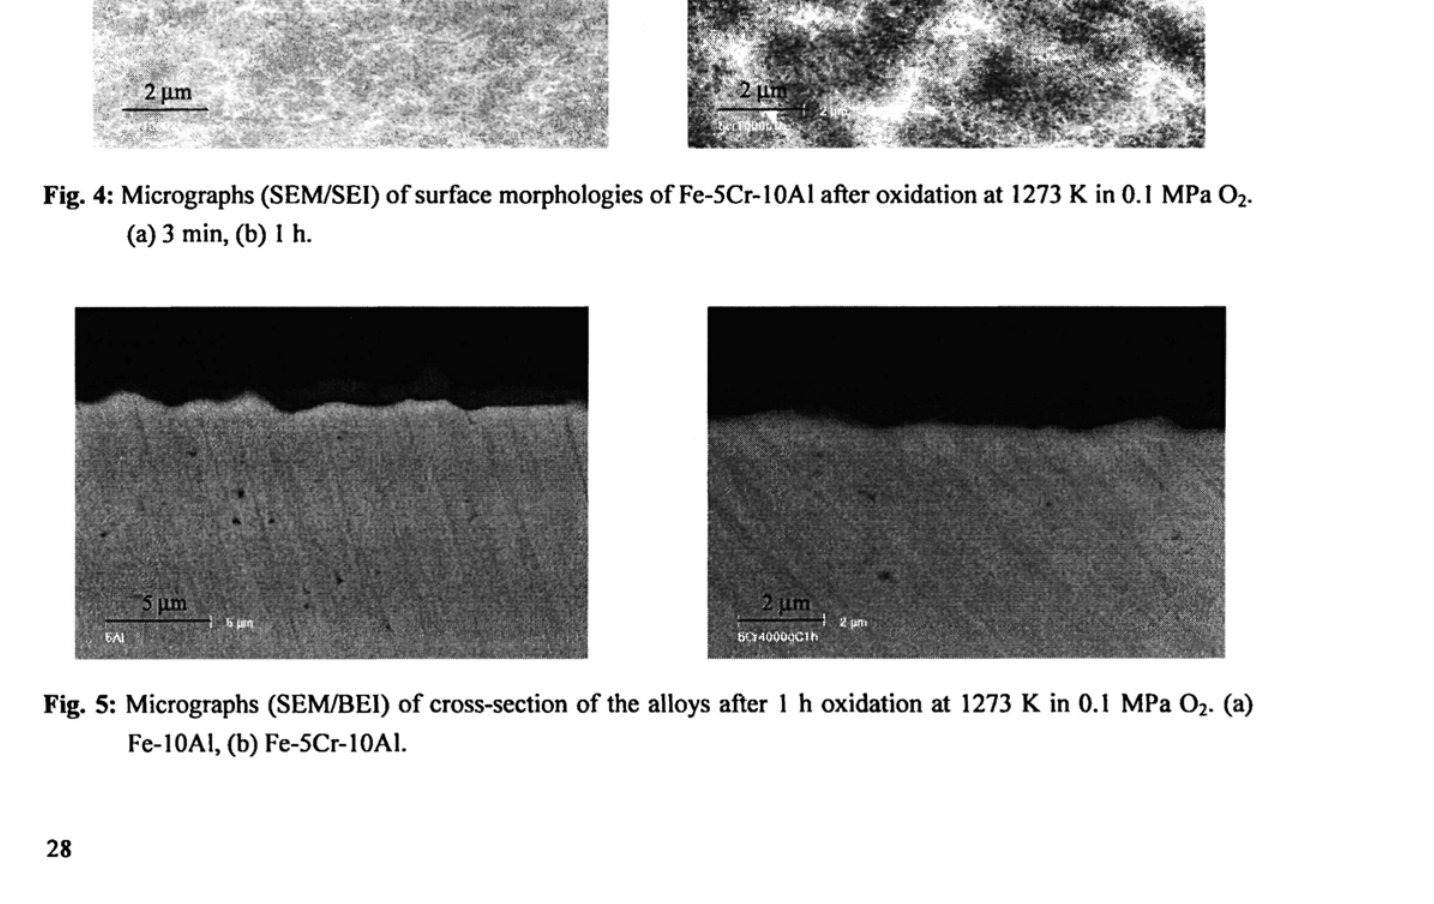
Fig. 4: Micrographs (SEM/SEI) of surface morphologies of Fe-5Cr-10Al after oxidation at 1273 K in 0.1 MPa O